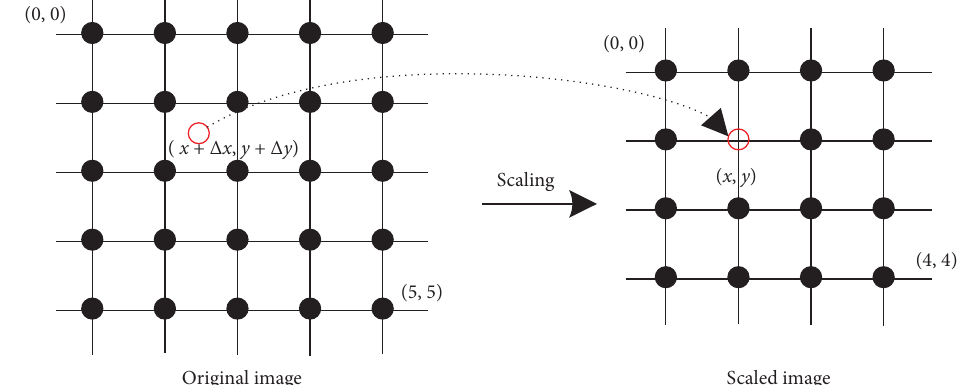
Figure 2: Schematic diagram of pixel position